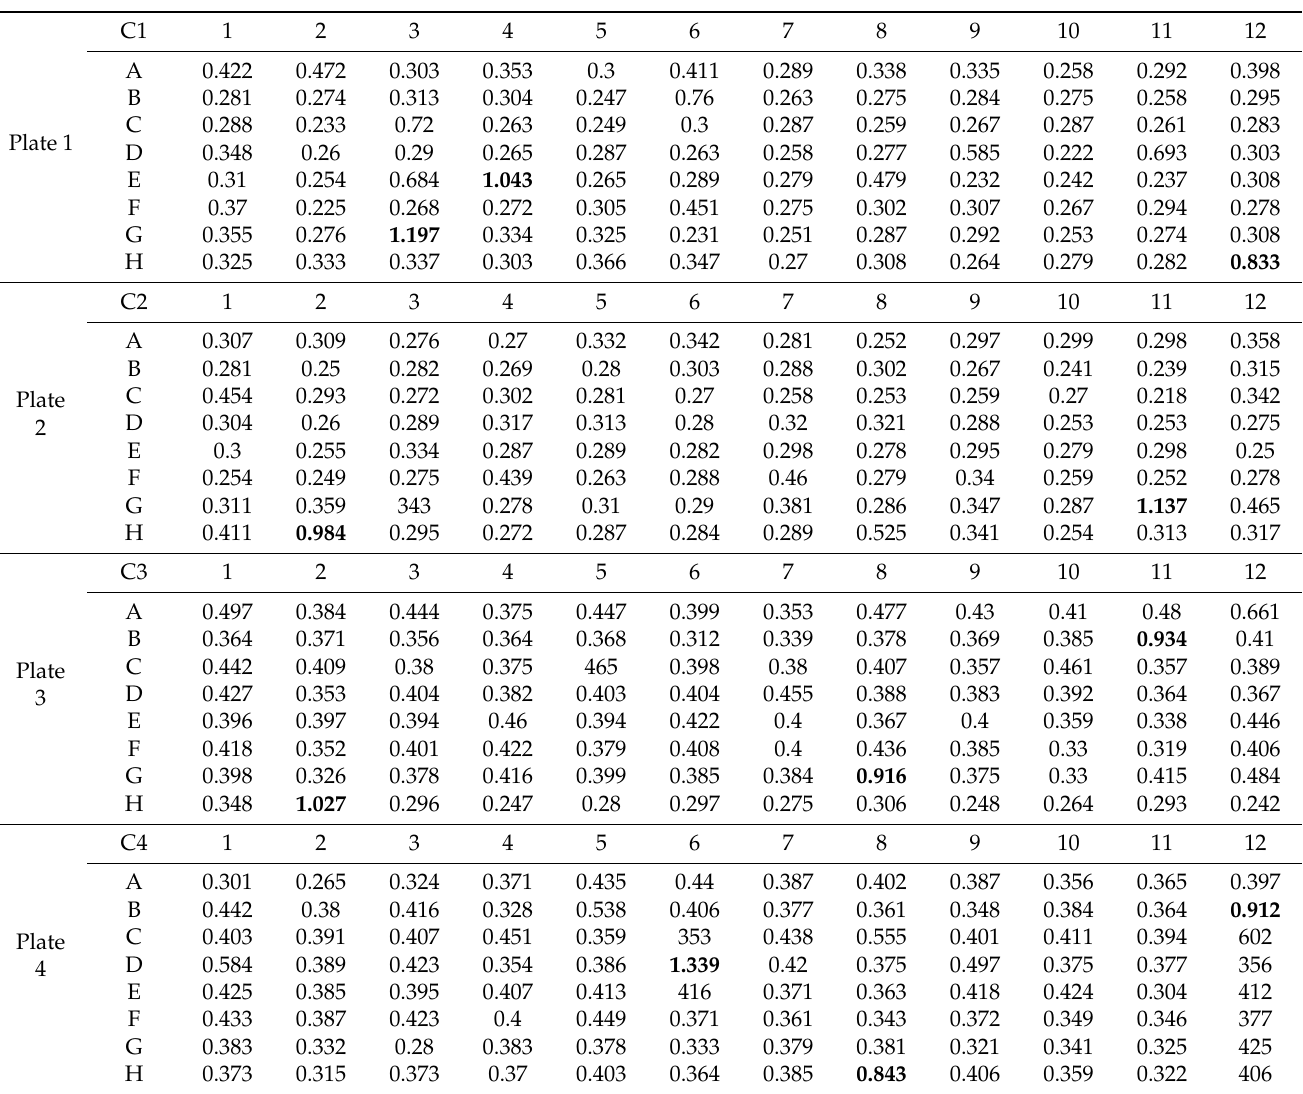
Table 3. Indirect ELISA for primary